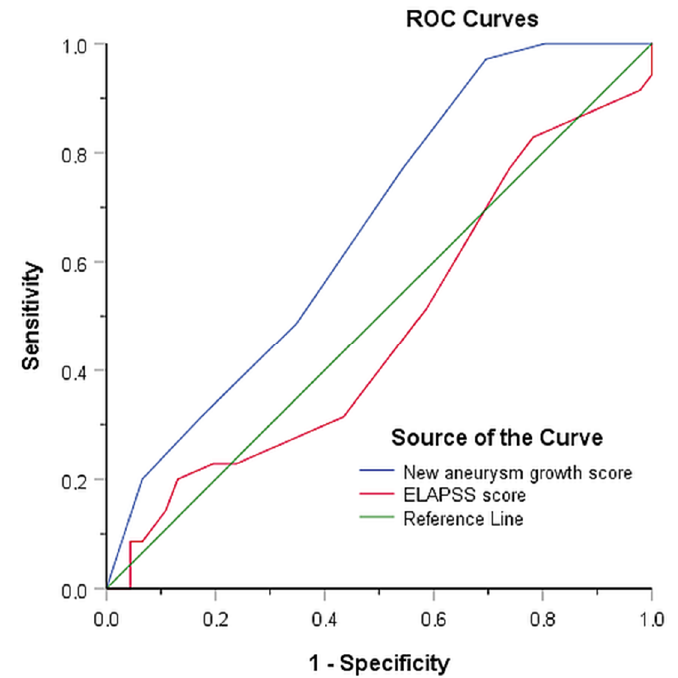
Figure 1. Receiver operating characteristic curves of growth scores for predicting the long-term growth of unruptured intracranial aneurysms. See text for statistics of the curves. The difference between the scores for area under the curve (AUC) was significant ( p < 0.05). ROC = Receiver operating characteristic. Table 3. Aneurysm growth scores and number of patients with an aneurysm growth.